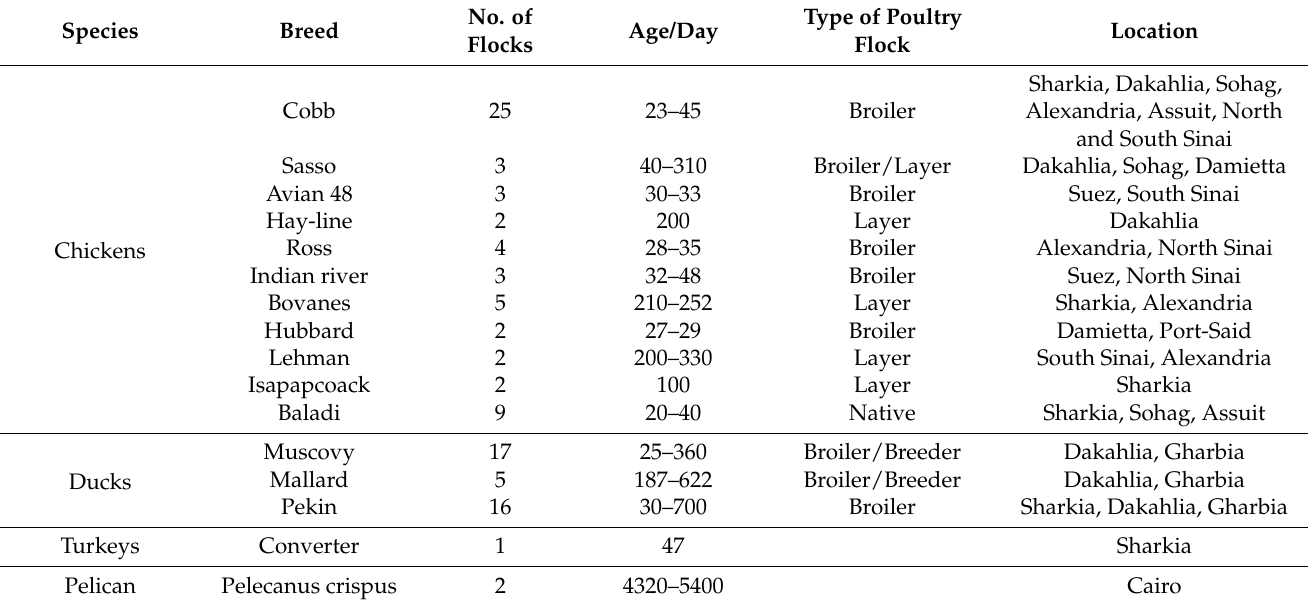
Table 1. Details of collected samples from domestic birds in Egypt, during 2019–2020. No. of Breed